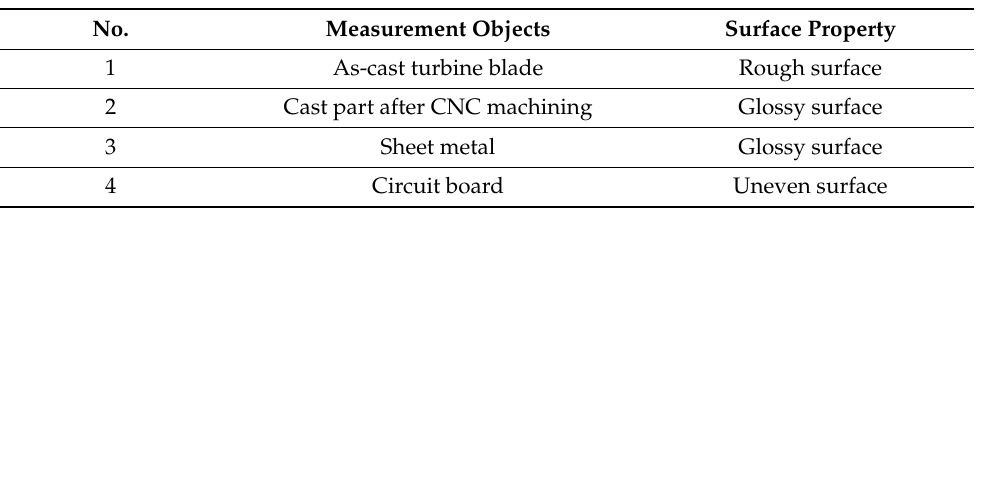
Table 1. Four metal components and their surface